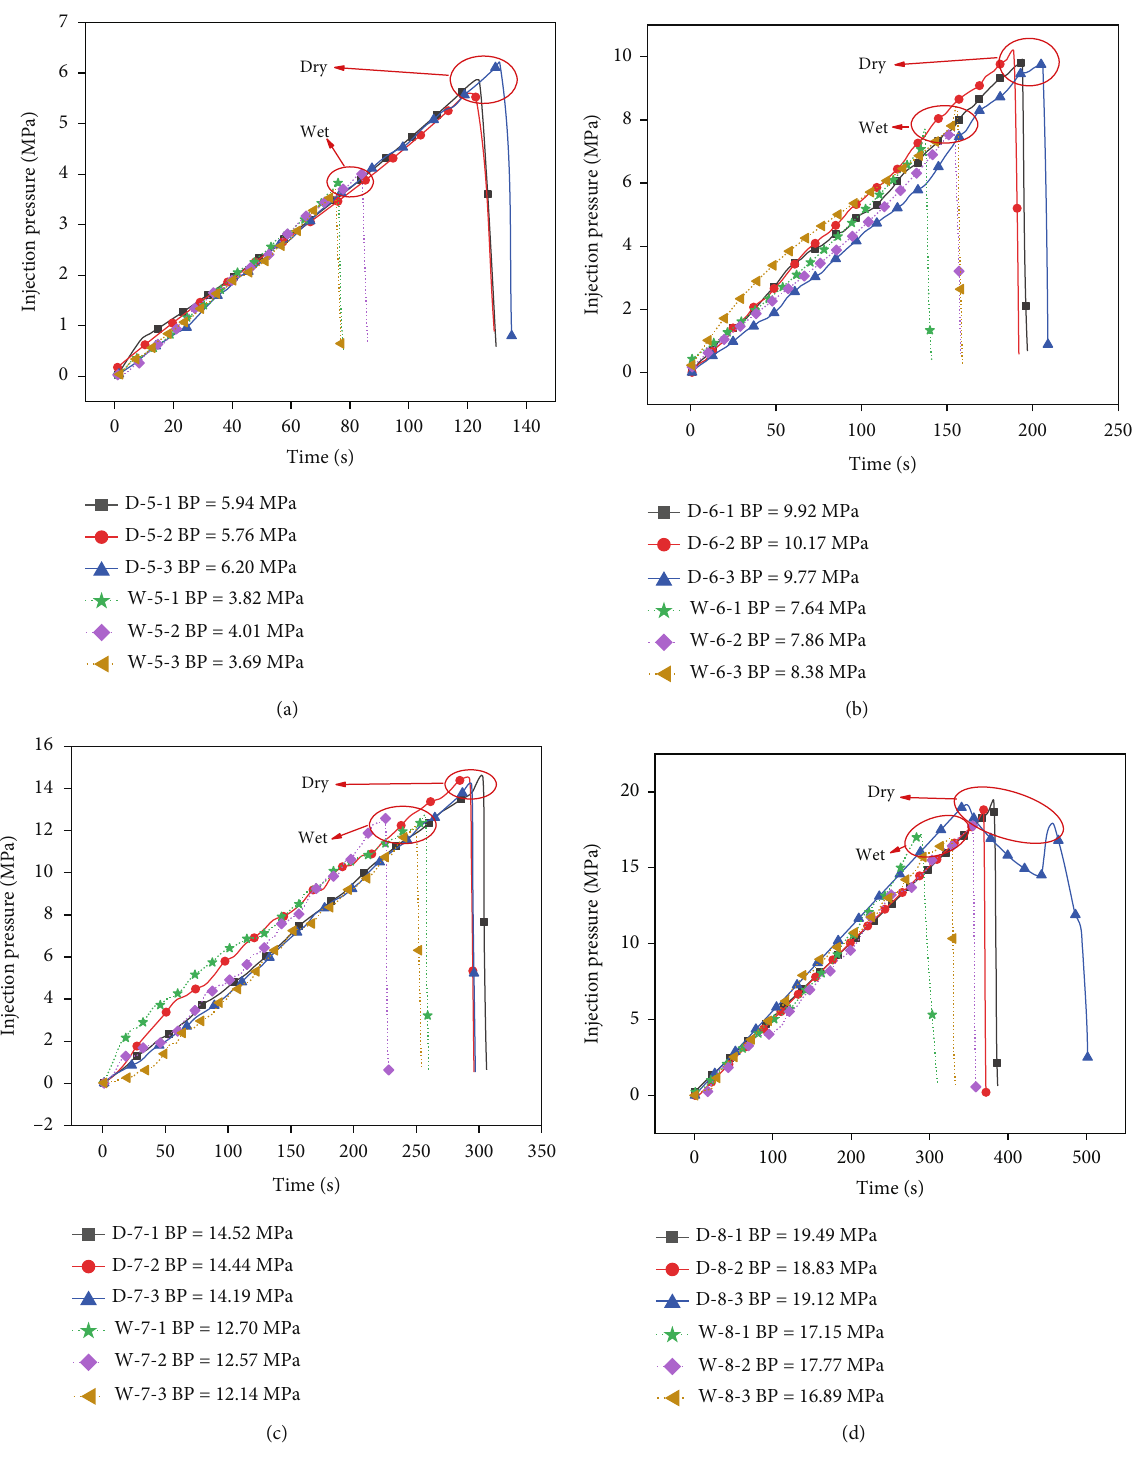
Figure 8: The nitrogen fracturing curves of dry and saturated parallel bedding shales after LN (a) con fi ning pressure = 3MPa ; (b) con fi ning pressure = 6 MPa ; (c) con fi ning pressure = 9MPa ; (d) con fi ning pressure = 12 MPa